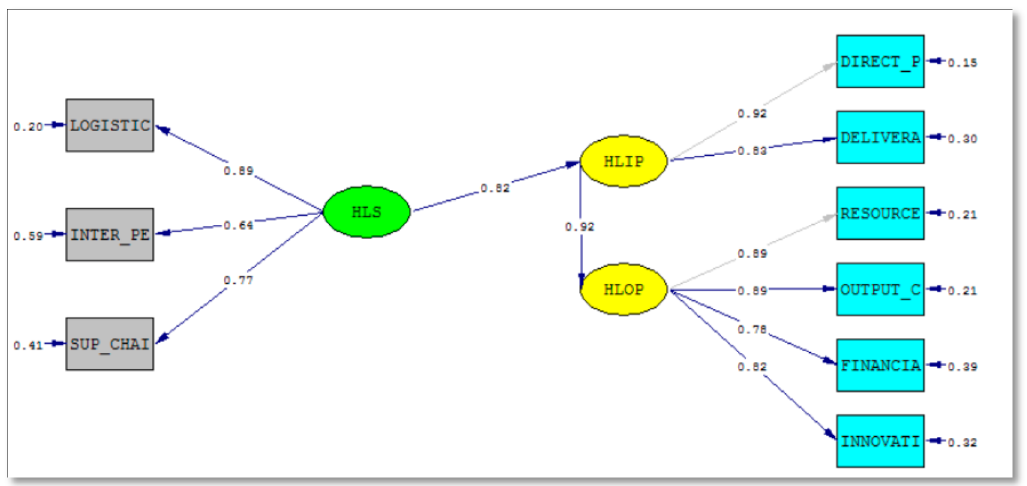
Figure 11. Structural model (Source: LISREL output).